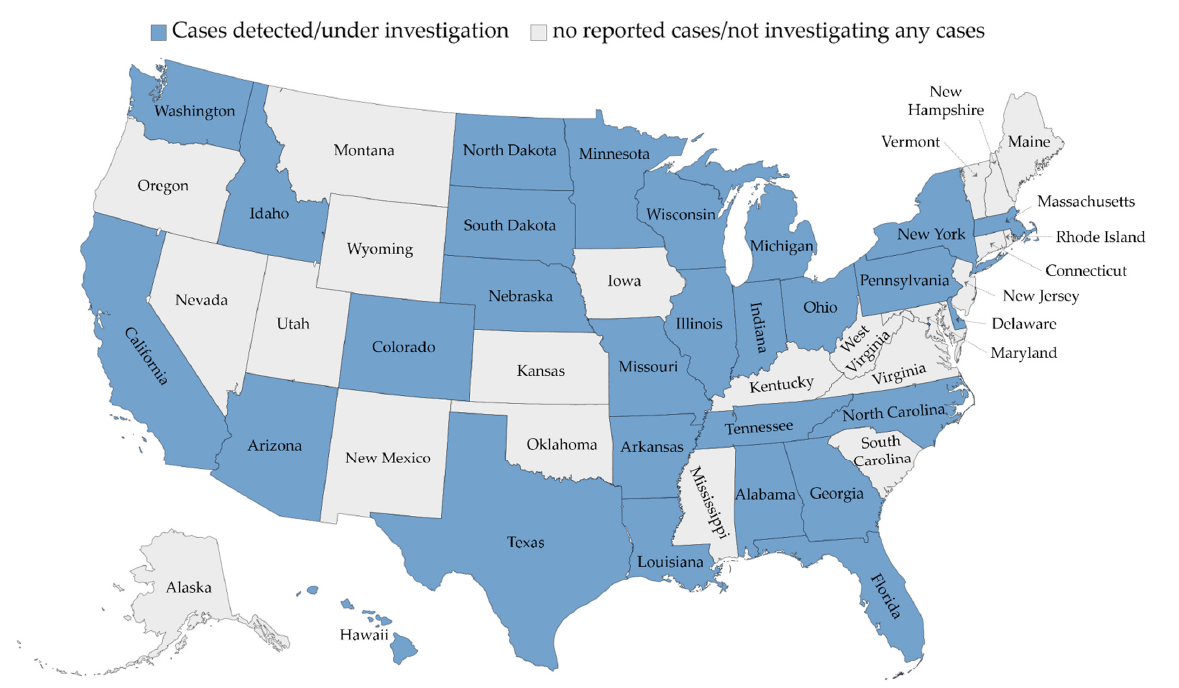
Figure 2. The distribution of acute non HepA ‐ E hepatitis in the United States as of 13 May 2022. The map was generated in Microsoft Excel, powered by Bing, © GeoNames, Microsoft, Navinfo, TomTom, Wikipedia.